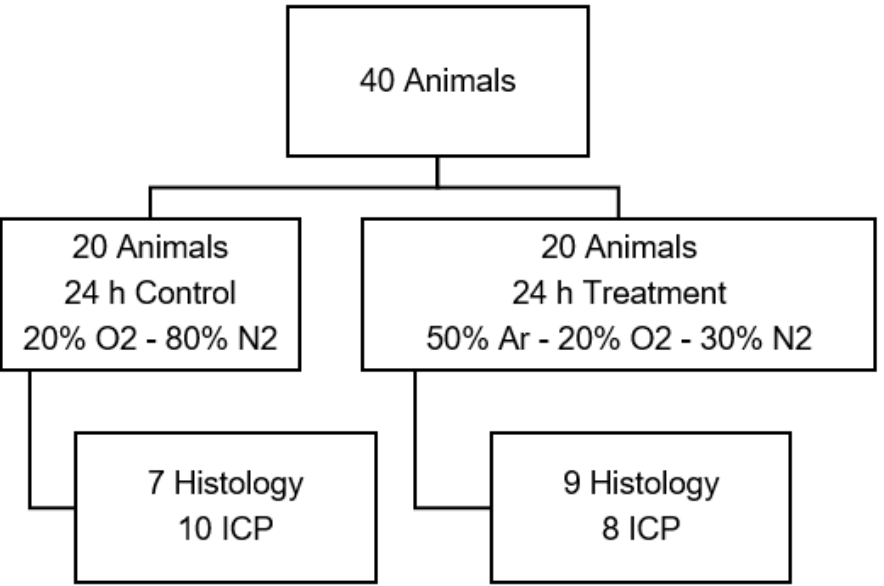
Figure 3. Animal distribution of test series C with physiological oxygen levels. (Ar: argon; O2: oxy- gen; ICP: intracranial pressure measurement). O2: oxygen; ICP: intracranial pressure